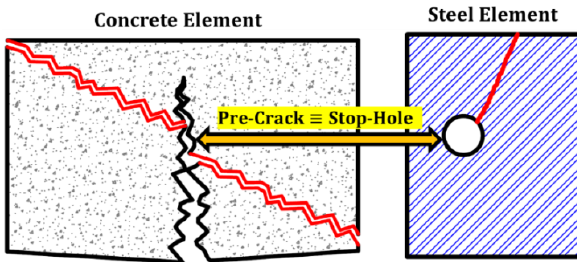
Figure 14. Stopping mechanism of crack growth in concrete and steel elements.